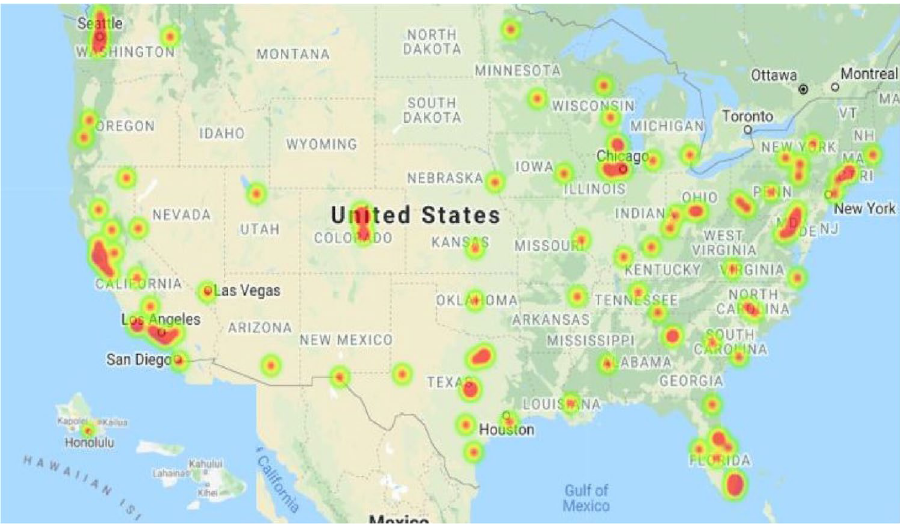
Figure 1. Heatmaps shown in the map represent the data collected by Mother Jones. The data shows the mass-shootings from years 1981 to 2021. More red areas means, multiple mass-shootings in that area. Software: Location History Visualizer, Source: https:// locat ionhi story visua lizer. com/ heatm